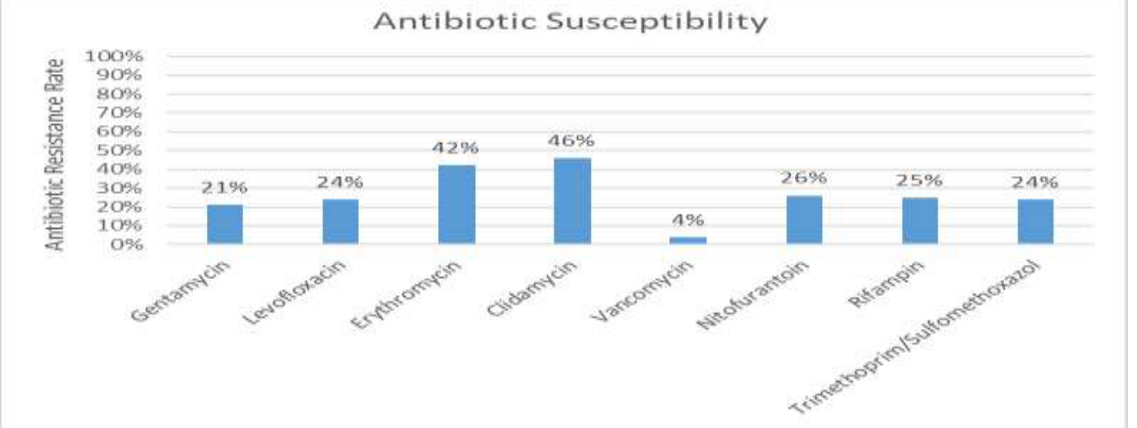
Figure 3.Antibiotic susceptibility profile of 72 MRSA isolates against eight antibiotics agents of